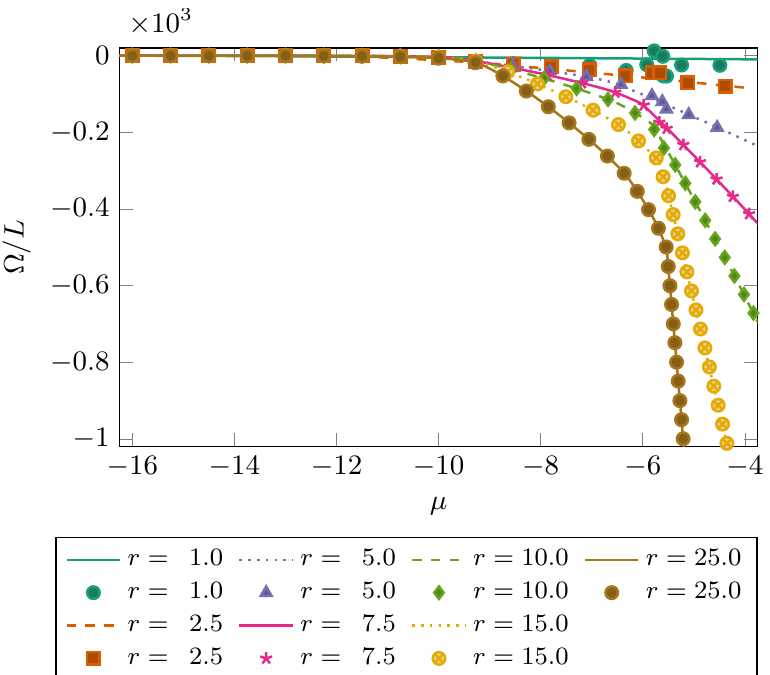
Figure 8. Dimensionless 2D grand potential, Ω / L , as a function of the dimensionless chemical potential, µ , for a Lennard-Jones fluid. Only the simulation results when χ = 1 are shown. The different lines show the results of the cDFT simulations while the symbols show the grand potential as reconstructed from the Minkowski functionals and one set of Minkowski functional coefficients: pressure, p ( µ , T ) , surface tension, σ ( µ , T ) , bending rigidity, κ ( µ , T ) , and the pseudo pressure and surface tension terms p (cid:48) ( µ , T ) and σ (cid:48) ( µ , T )